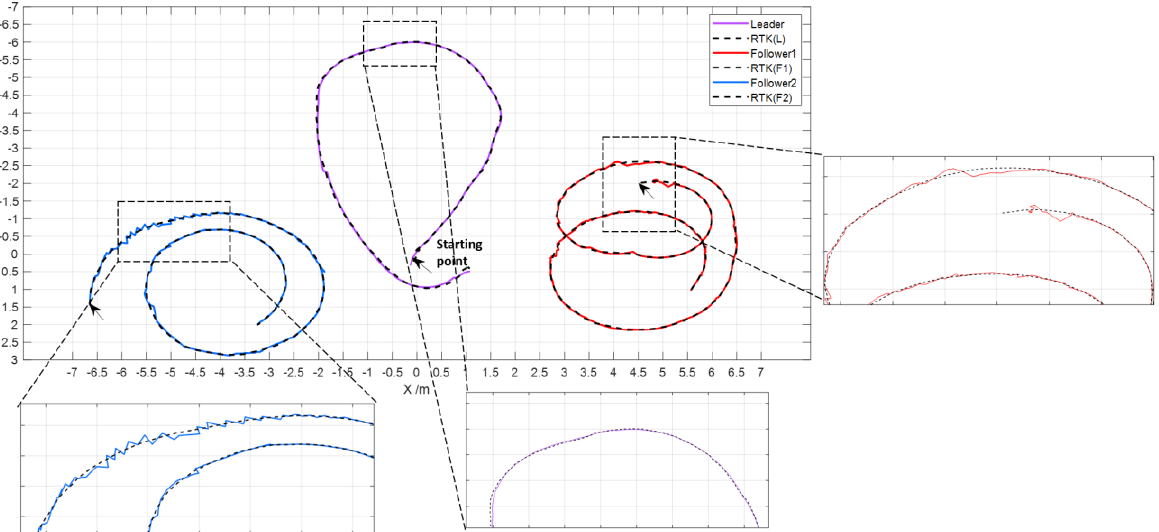
Figure 8. Co-localization experiment of three AGVs, including a Leader and two Followers . The origin of world frame is the starting point of Leader. We zoomed in on the details to better show the experimental results.